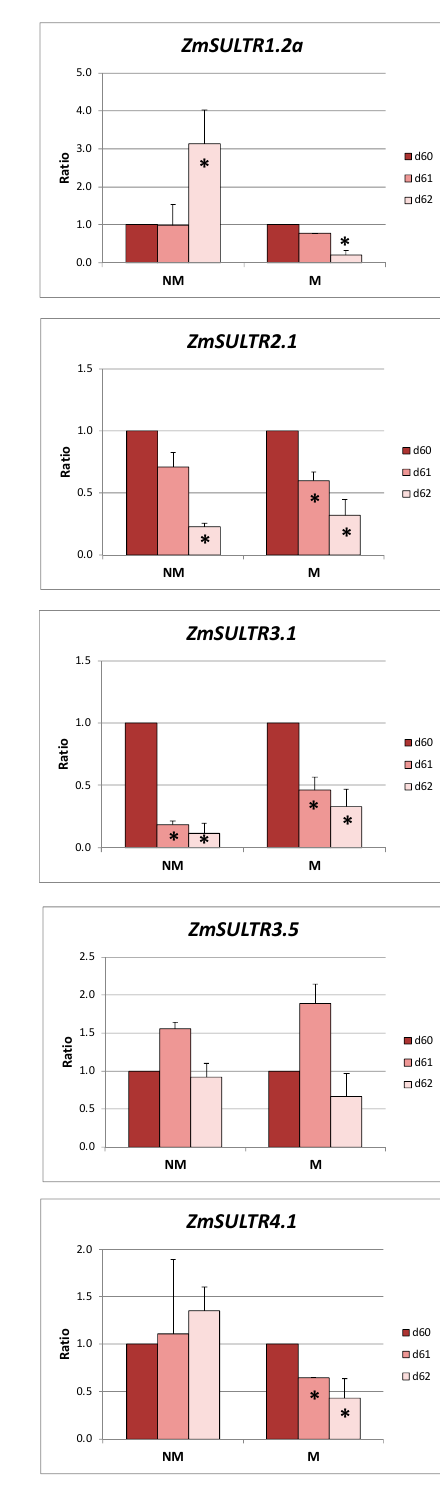
Figure 2. Relative expression ratios (the mean of six biological replicates ± standard error (SE)) of the sulfate transporters in the roots of non-mycorrhizal (NM) and mycorrhizal (M) maize plants before (left column) and after (right column) the supply of sulfate. d30/d45/d60/d61/d62: days after sowing. Significant differences ( p < 0.05) between the samples and the respective controls are represented by an asterisk (*).